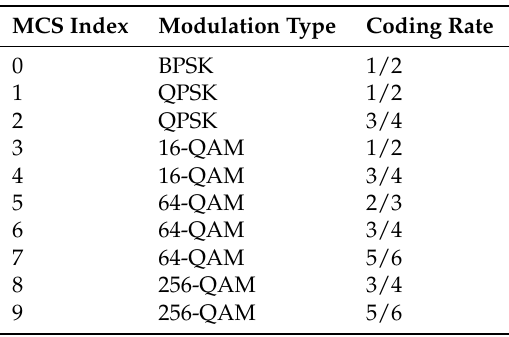
Table 2. Modulation and coding